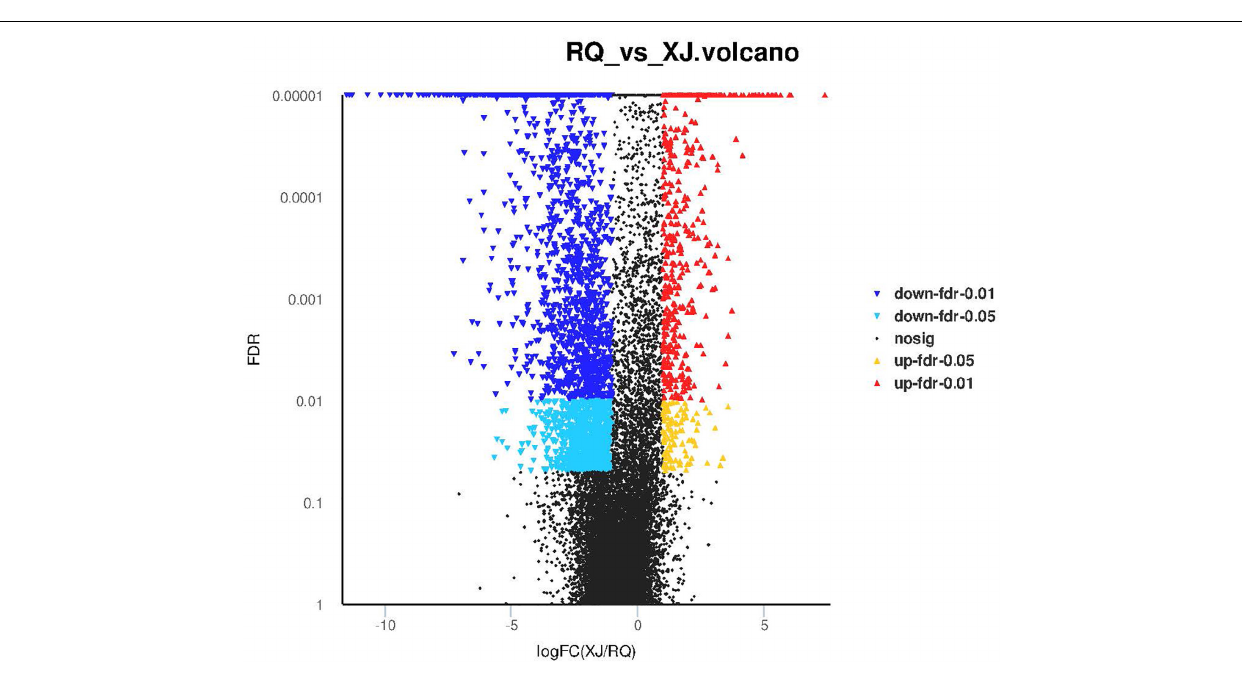
FIGURE 4 | The number of differentially expressed genes of surface-cave fish groups. X -axis shows the differences in expression given as the log values, and the Y -axis shows significant differences in expression as FDR values in the Volcano plot; up-regulated genes and down-regulated genes are indicated by red dots and blue dots,